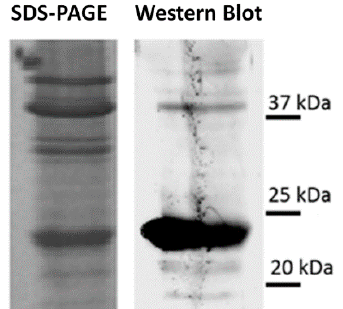
Figure 3. Reaction of a chitinase from S. griseus with anti-peptide Ab. Three micrograms of S. griseus chitinase was loaded onto 12% SDS-PAGE. Monoclonal anti-peptide Ab (5 µg·IgM·mL − 1 ) was used to detect the reaction with S. griseus chitinase. A Coomassie-stained gel corresponding to the counterpart challenged with Ab is also shown for comparison. Protein molecular mass markers are shown on the right.